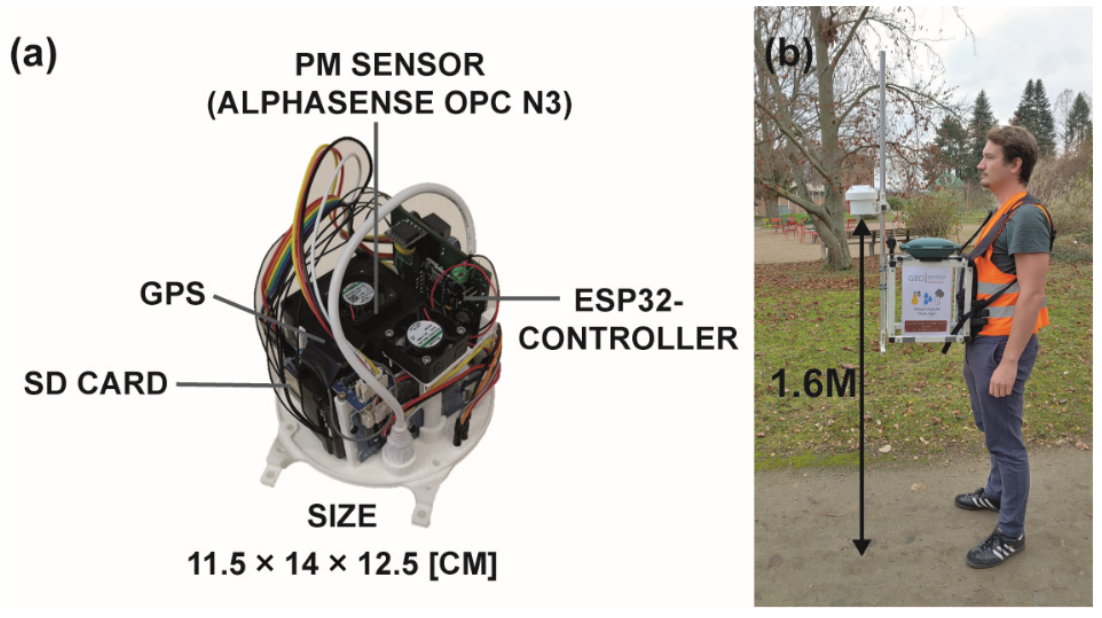
Figure 2. ( a ) Design and components of the measurement device (dimensions: 11.5 cm × 14 cm × 12.5 cm), and ( b ) picture of a person carrying the rack.